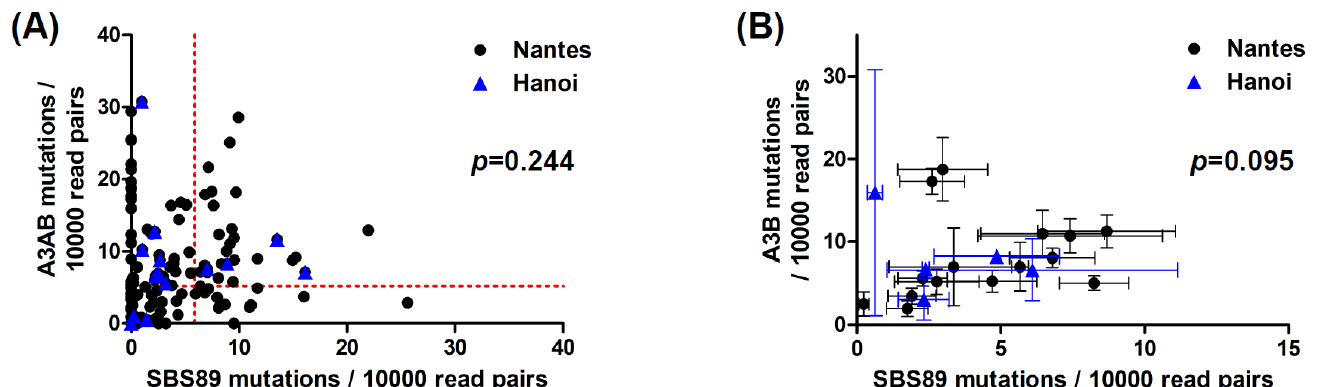
Figure 3. Association between APOBEC3A/B and SBS89 mutation rates. ( A ) Correlation between APOBEC3A/B and SBS89 mutation rates in individual samples. Dotted red lines show the 95th percentiles of APOBEC3A/B and SBS89 mutation rates observed in plasmid controls (n = 135). ( B ) Correlation between mean APOBEC3A/B and SBS89 mutation rates in 15 Nantes patients and the 5 Hanoi patients for whom at least two data points were available. Error bars show SEM. The Spearman’s rank correlation coefficient was used for statistical analysis of the complete data set without distinction between Nantes and Hanoi patients.